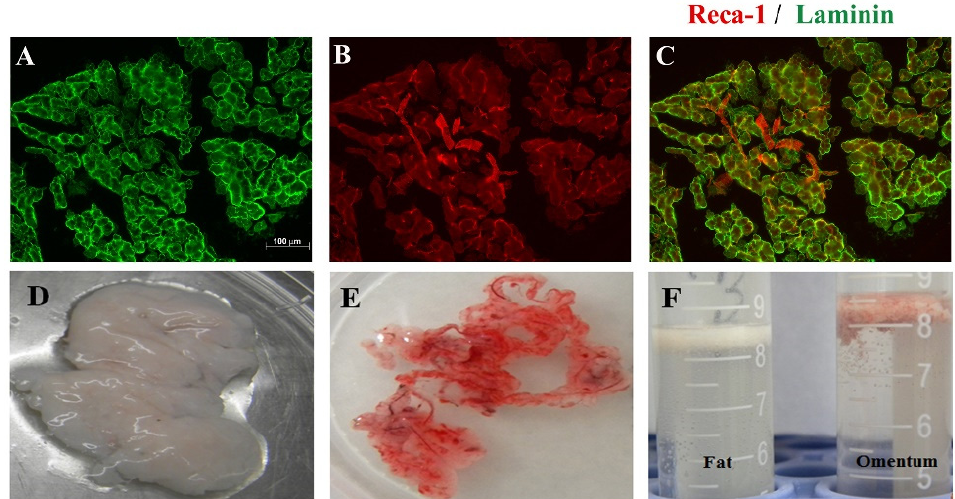
throughout 6 weeks post-injury (from the 3rd to the 6th week, 5.0 vs. 8.2, 5.2 vs. 8.3, 5.3 vs. 8.4, 5.5 vs. 8.6, p < 0.05, respectively).